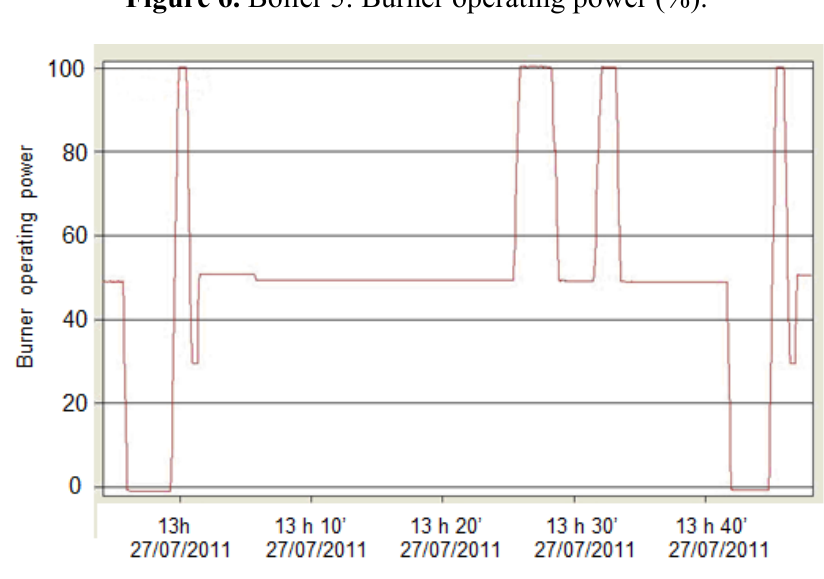
Figure 6. Boiler 5: Burner operating power